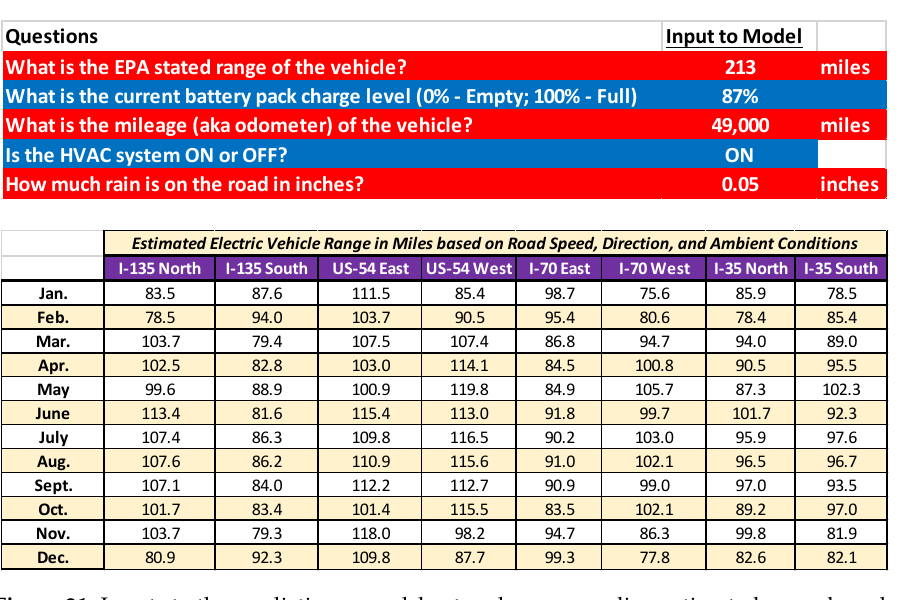
Figure 21. Inputs to the predictive spreadsheet and corresponding estimated range based on route and month of the year.